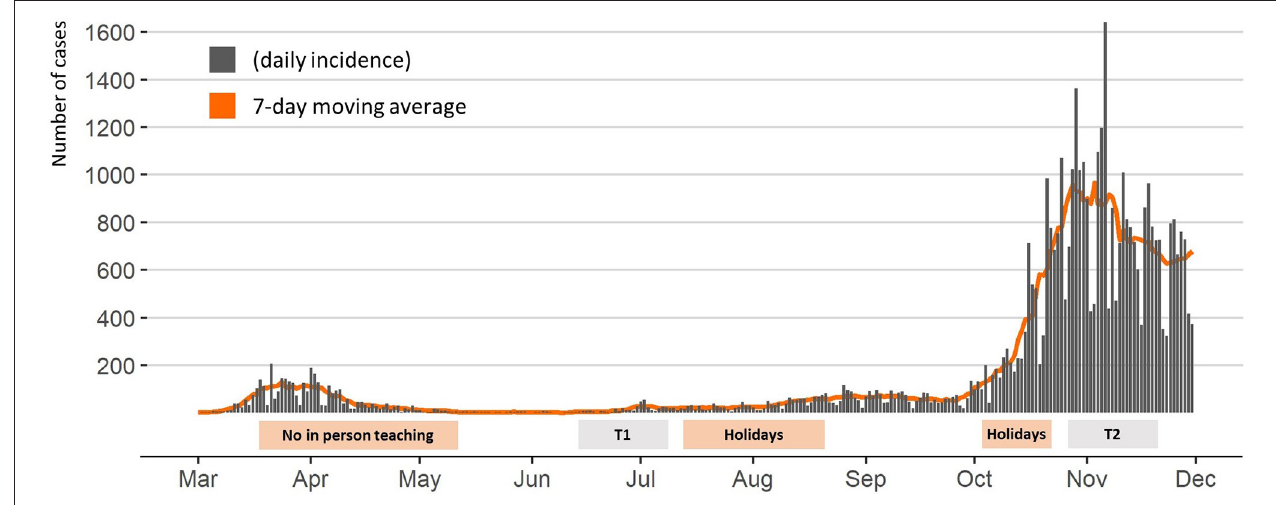
FIGURE 1 | Daily incidence of SARS-CoV-2 cases in the canton of Zurich, Switzerland, and school operation between January and December 2020. T1, June 16 to July 9, 2020; T2, October 26 to November 19,